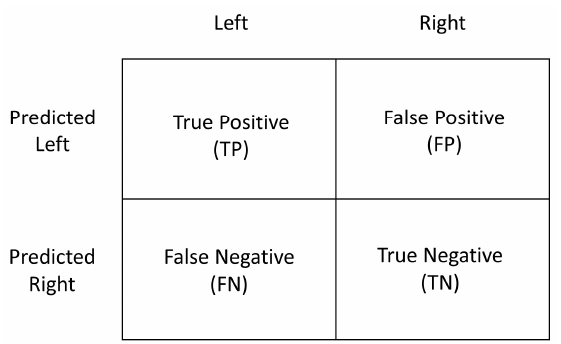
Figure 6. Performance metric.